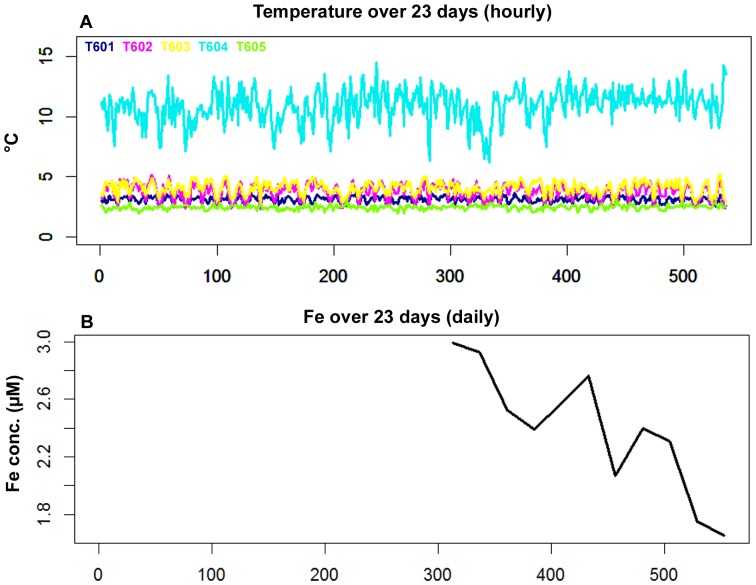
Overview of the environmental variables measured during the continous imagery recording.Overview of environmental variables measured in the vicinity of the filmed assemblage. Recording period represented here corresponds to the imagery analysis, i.e. 2011-10-07 at 8 h to 2011-20-30 at 14 h, for (A) Temperature (B) Fe concentrations. Gaps in the data during this period were due to instrument-dependent failed recordings.